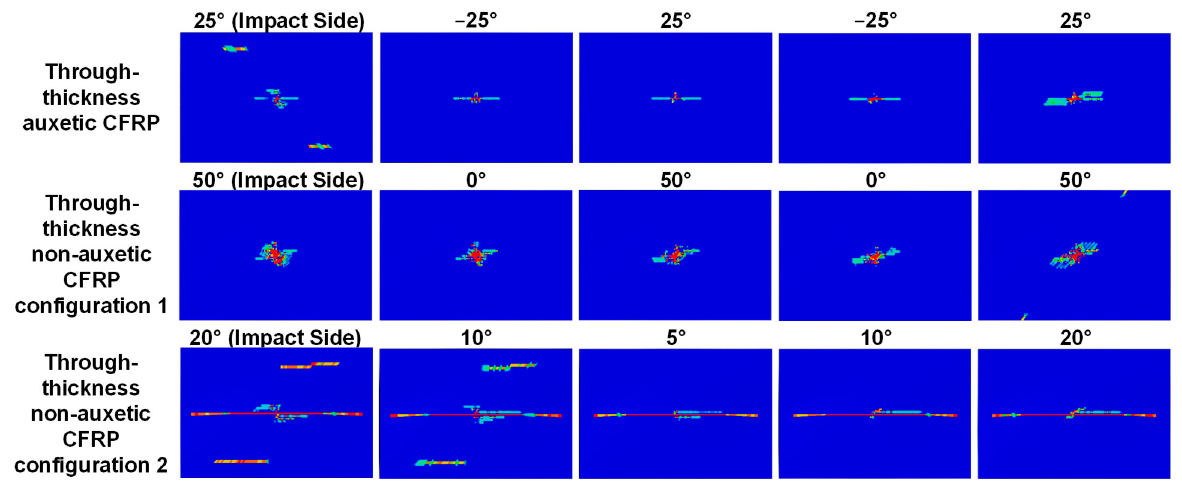
Figure 9. Effect of the through-thickness negative Poisson’s ratio on the matrix tensile damage: comparison of predicted matrix tensile damage pattern in each ply of the auxetic CFRP composite (layup: [25 2 / − 25 2 /25 2 / − 25 2 /25 2 ], results shown in the first row) and the corresponding non-auxetic laminates in two configurations (layups: [50 2 /0 2 /50 2 /0 2 /50 2 ] and [20 2 /10 2 /5 2 /10 2 /20 2 ], results shown in the second and third rows), at an 8 J impact. The red color indicates complete damage while the blue color indicates no damage.